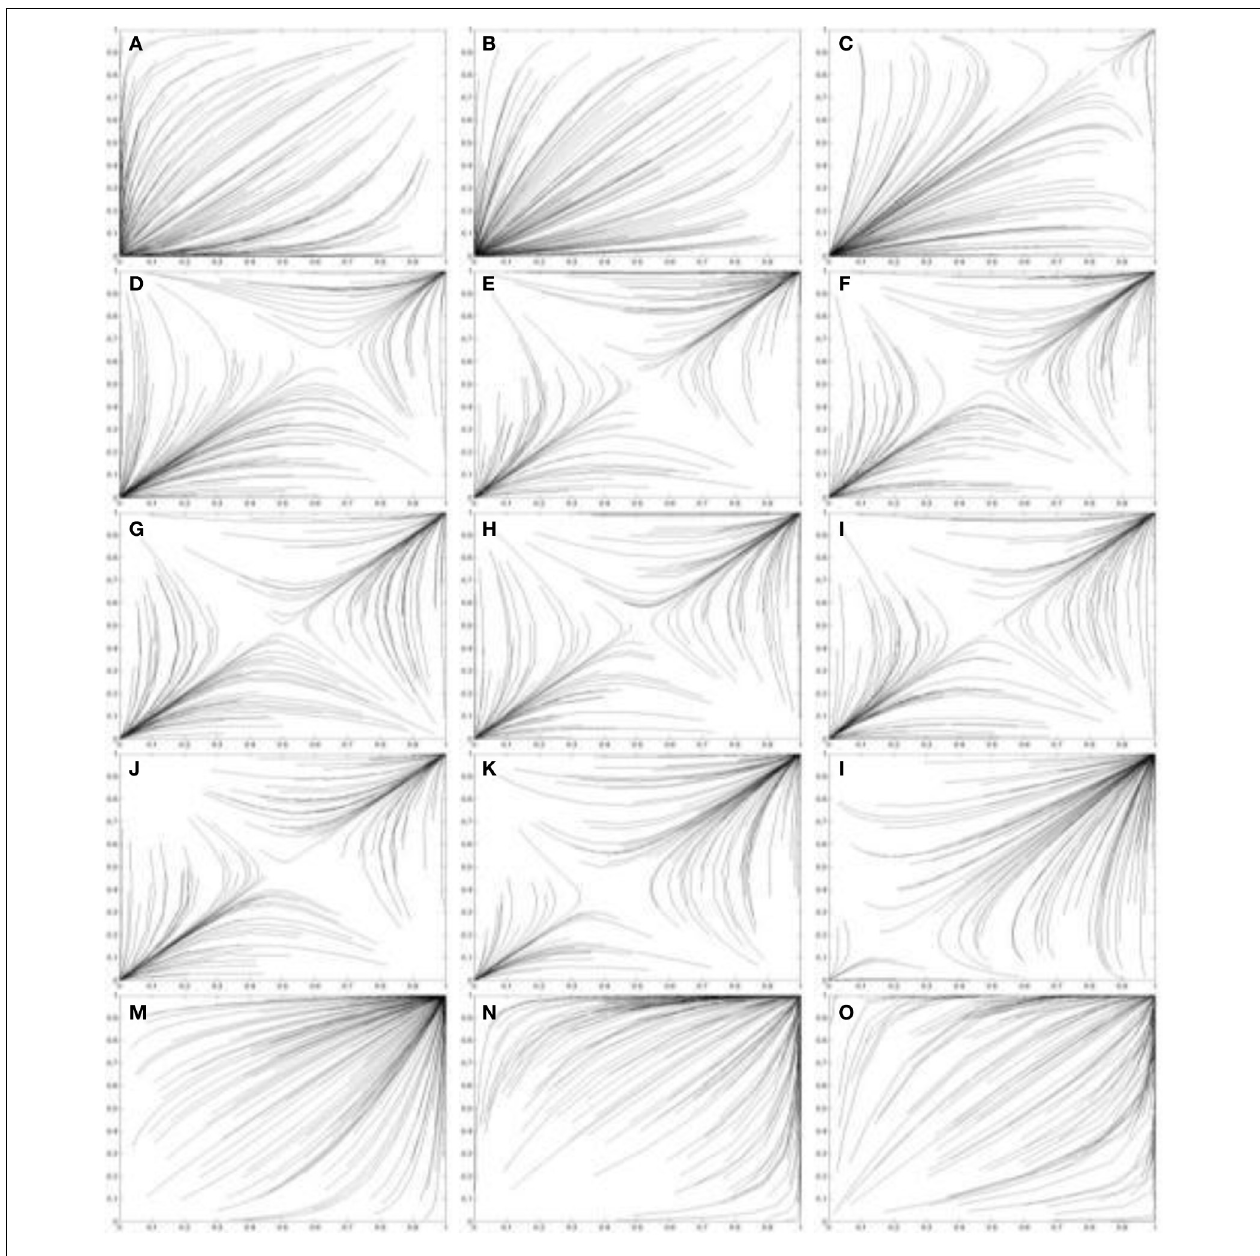
(E) I ∗ j = 3 . 0; (F) I ∗ j = 2 . 8; (G) I ∗ j = 2 . 6; (H) I ∗ j = 2 . 4; (i) I ∗ j = 2 . 2; (J) I ∗ j = 2 . 0; (K) I